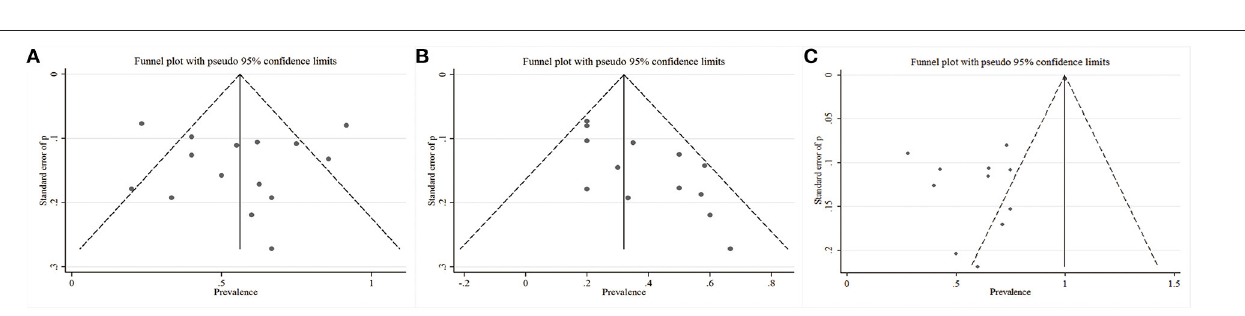
FIGURE 3 | Forest plots showing a summary of the evaluation of the respond rates in the RCTs.